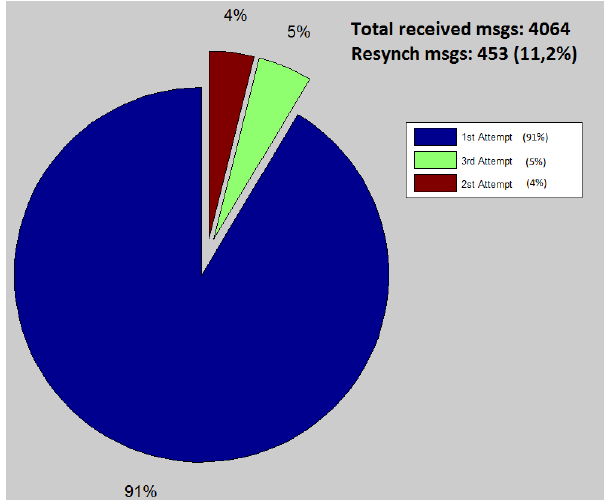
Figure 5. Messages received by the UAV along the experiment.